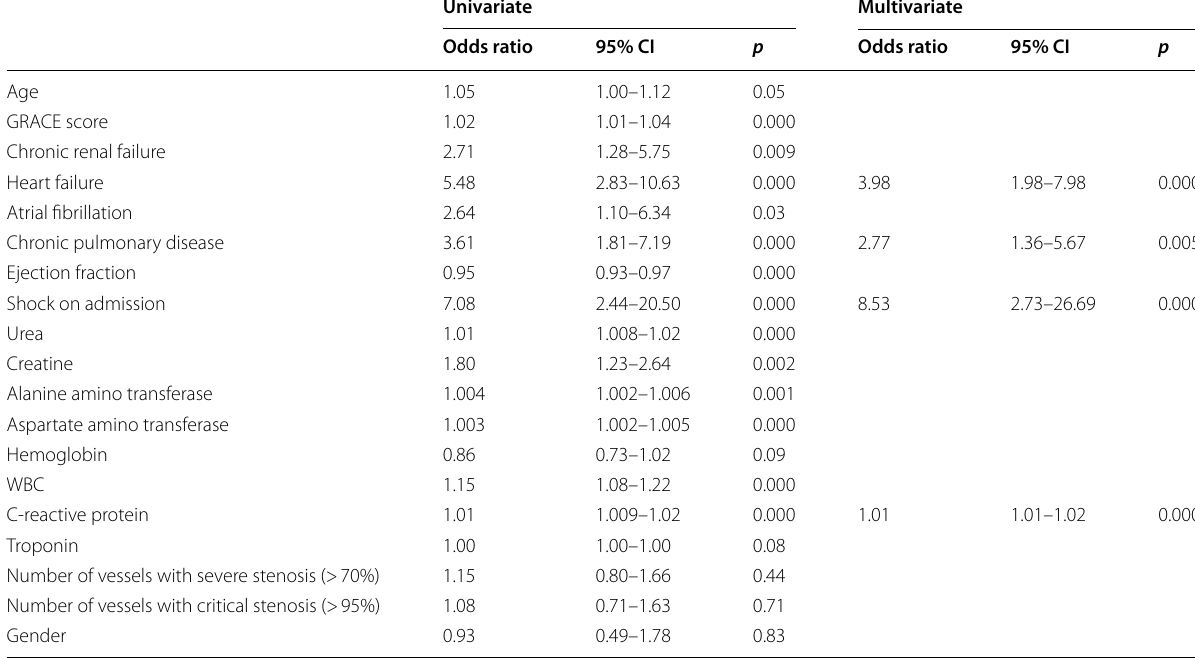
Table 5 All-cause mortality univariate and multivariate regression analysis Univariate